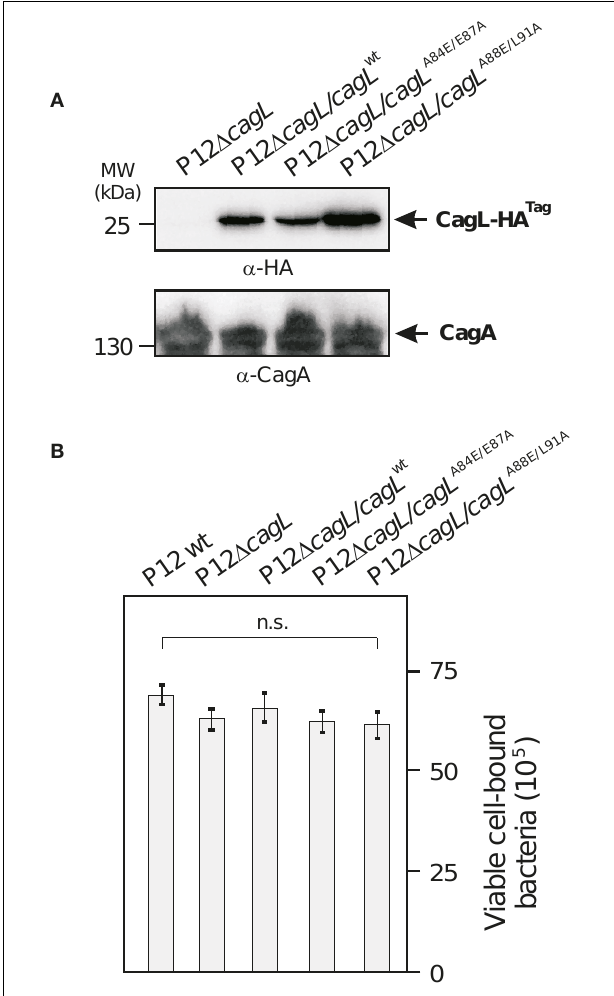
FIGURE 6 | Effect of CagL deletion or point mutations in the CagL RHS motif on binding of H. pylori toAGS cells. (A) A Δ cagL deletion mutant in strain P12 was generated by replacing the cagL gene with an aphA3 cassette. CagL WT and two CagL mutants carrying either the A84E/E87A or A88E/L91A point mutations were expressed as HA-tag fusion proteins from genes integrated into the ureA locus of the P12 Δ cagL strain.The correct expression of each of these CagL variants was verified byWestern blotting using an α -HA antibody.The α -CagAWestern blot was performed as loading control. (B) AGS cells were infected with each of these strains for 4h using MOI = 100, followed by determination of the amount of viable bound H. pylori per input strain . The quantification data indicate that each of these strains bound to AGS cells equally well with high efficiency. No significant differences in results were seen when MOI = 50 was used (data not